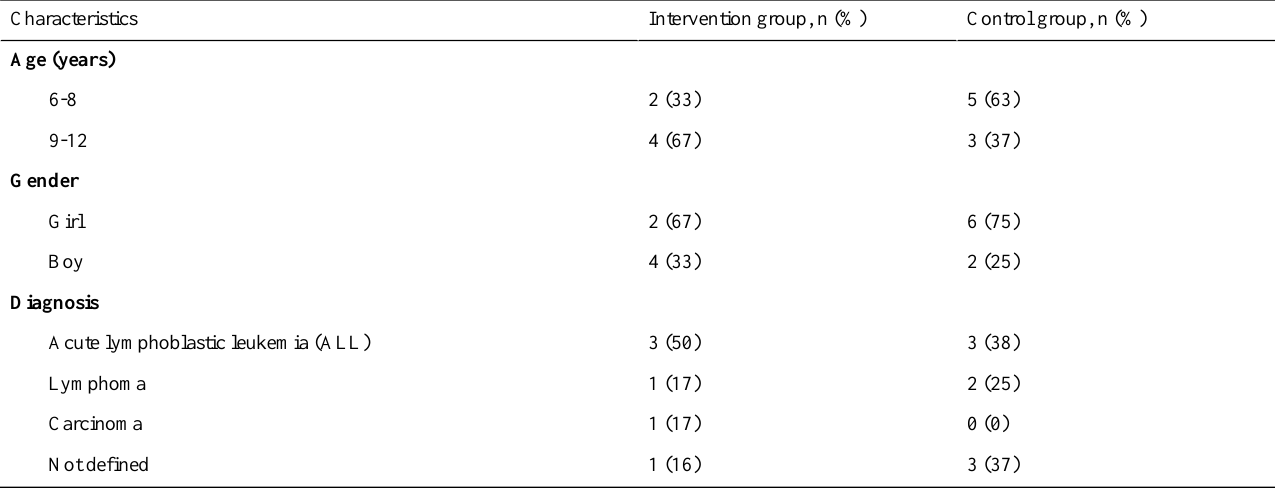
Table 1. Demographic characteristics of the